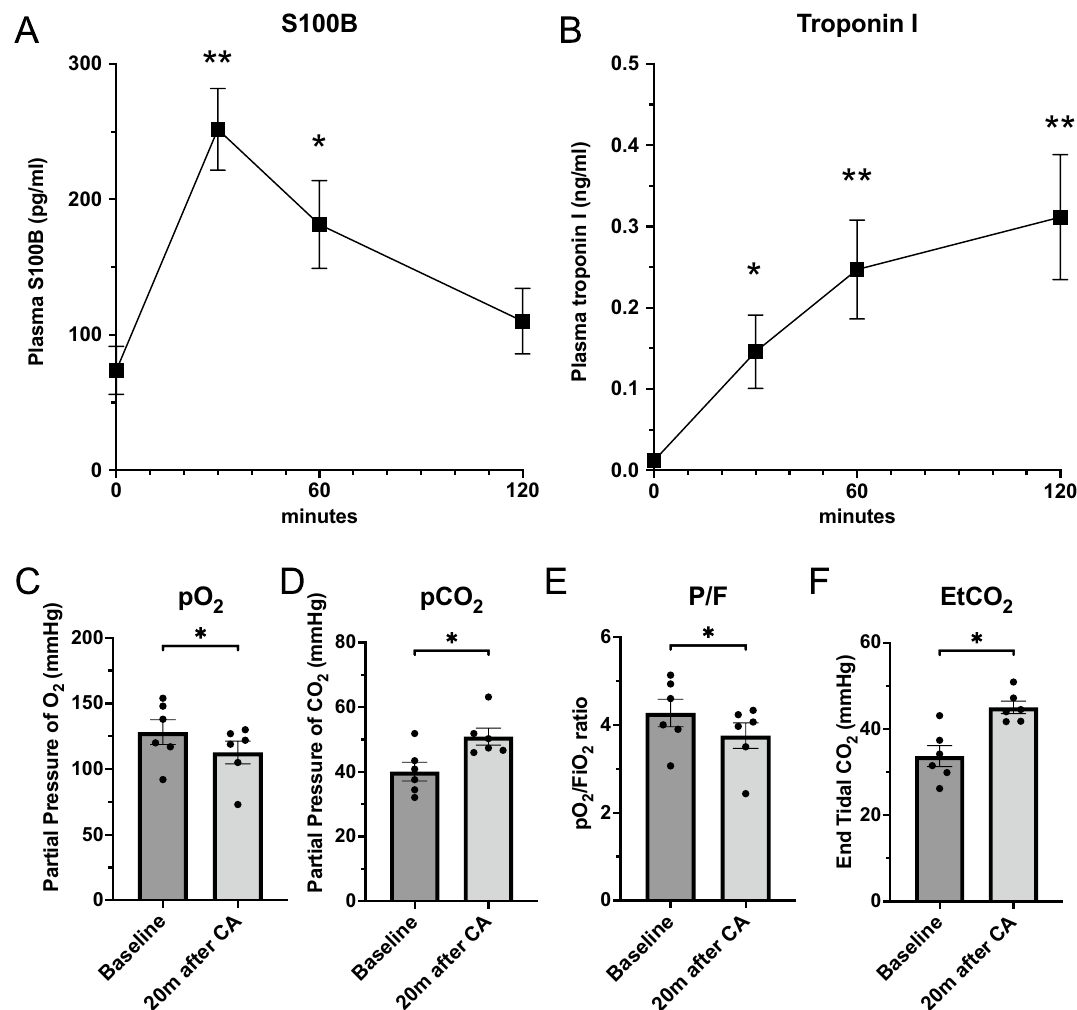
Figure 4. Plasma S100B concentration, plasma troponin I concentration, arterial blood gas analysis, and EtCO 2 after CA. ( A ) Plasma S100B concentrations were detected using rat S100B ELISA kit (MBS2021416). Baseline, 30 min, 1 h, and 2 h plasma samples of 8 rats, after CA were applied to measurement. S100B levels significantly increased at 30 min and 1 h, but not at 2 h after CA and resuscitation (baseline; 73.8 ± 17.7 pg/ml, 30 min; 251.8 ± 30.2 pg/ml, 1 h; 181.5 ± 32.4 pg/ml, 2 h; 110.1 ± 24.2 pg/ml). ( B ) Plasma troponin I concentrations were detected using rat cardiac troponin I ELISA kit (ab246529). Baseline, 30 min, 1 h, and 2 h plasma samples of 8 rats, after CA were applied to measurement. Troponin I levels significantly increased gradually over time after CA and resuscitation (baseline; 0.010 ± 0.004 ng/ml, 30 min; 0.146 ± 0.048 ng/ml, 1 h; 0.247 ± 0.065 ng/ml, 2 h; 0.312 ± 0.082 ng/ml). ( C–F ) Arterial blood gas analysis was performed using iSTAT. Data at baseline, and 20 min after CA were compared. ( C ) pO 2 was significantly decreased at 20 min after CA. ( D ) pCO 2 was significantly increased at 20 min after CA. ( E ) pO 2 /FIO 2 (P/F) ratio was calculated from pO 2 and FIO 2 . P/F ratio was significantly decreased at 20 min after CA. ( F ) End tidal CO 2 (EtCO 2 ) was measured throughout the procedure and significantly increased at 20 min after CA. N = 6. Data were shown as mean ± SEM. * P < 0.05, ** P < 0.01,